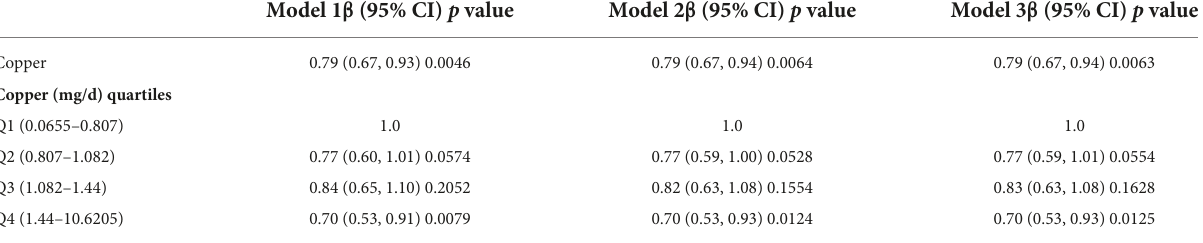
TABLE 5 Correlation analysis between copper intake and myocardial infarction after matching.